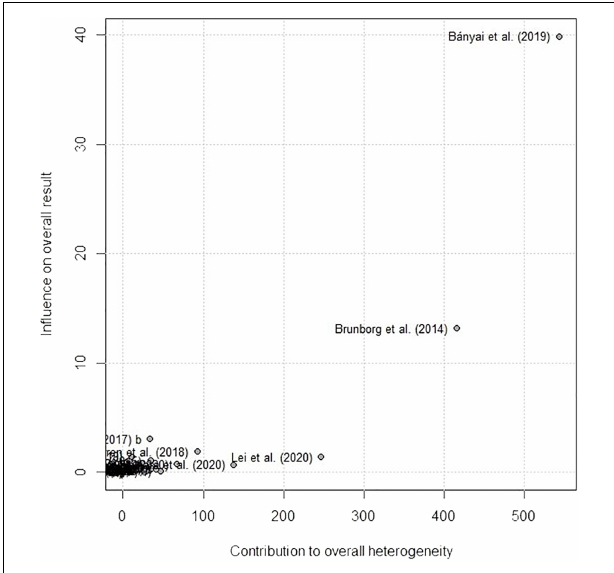
FIGURE 5 | Sensitivity analysis for game playtime and